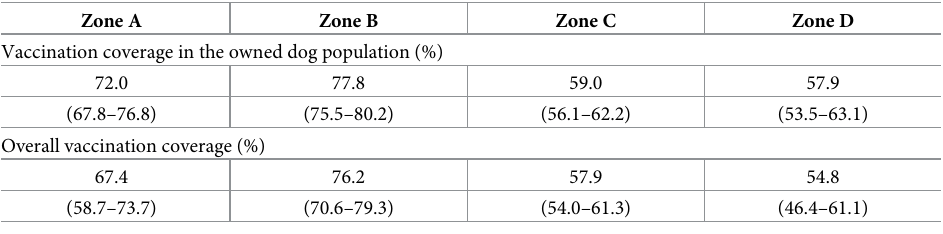
Table 5. Estimated vaccination coverage in owned and overall dog populations through the follow-up mass vacci- nation campaign. Zone A Zone B Zone